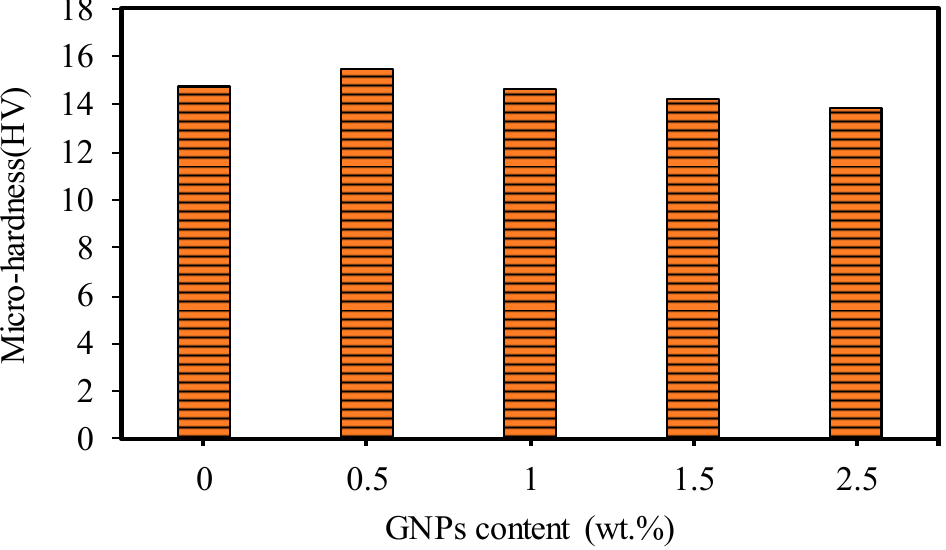
Figure 8. Hardness for the base Al 2 O 3 and GNP/Al 2 O 3 nanocomposites.